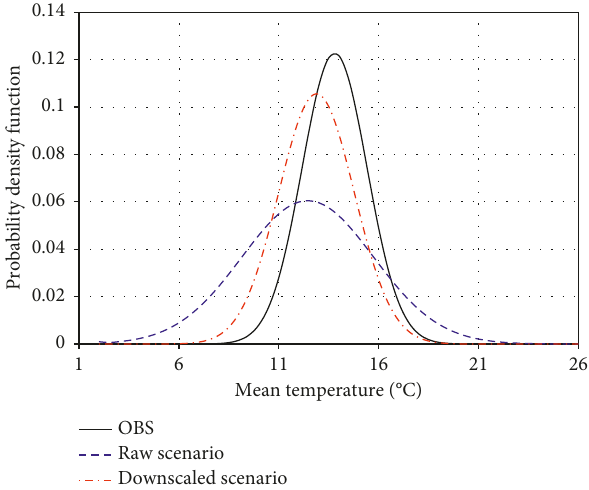
Figure 6: Observation and probability density functions before and after application of the SDQDM (average